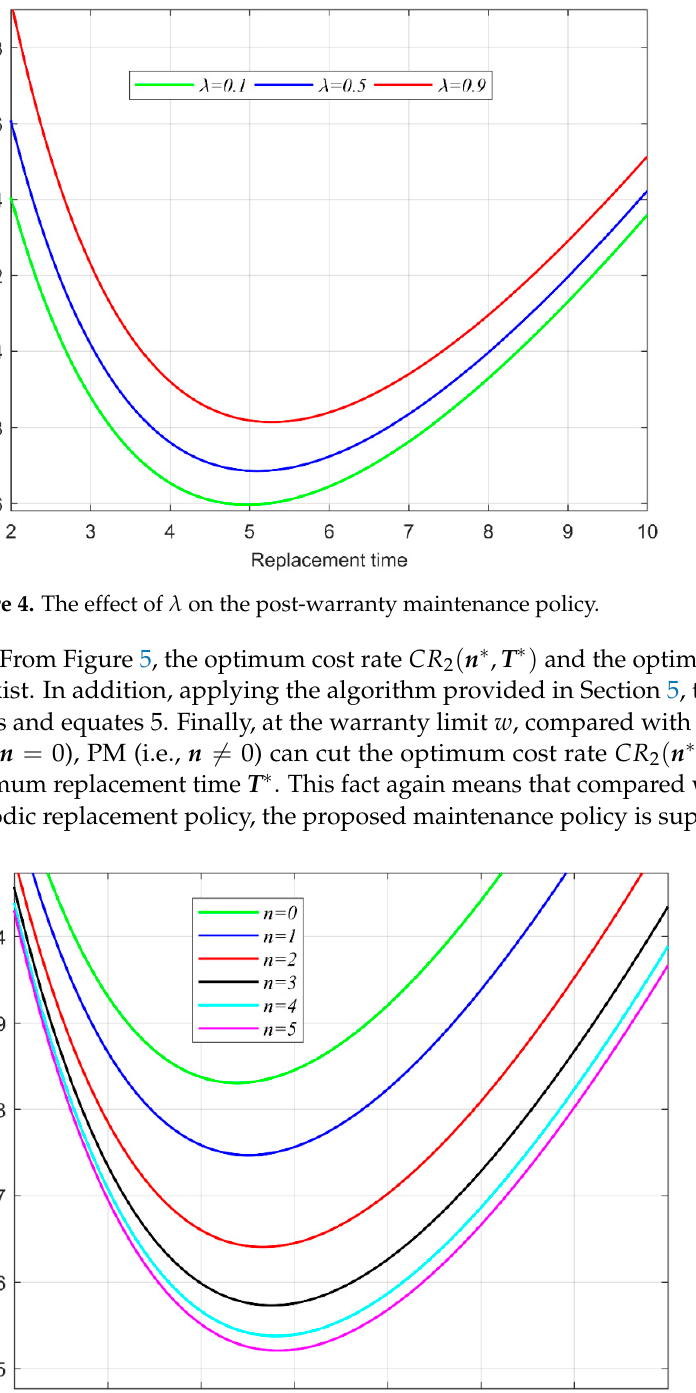
Figure 6. The post-warranty maintenance policy versus λ .